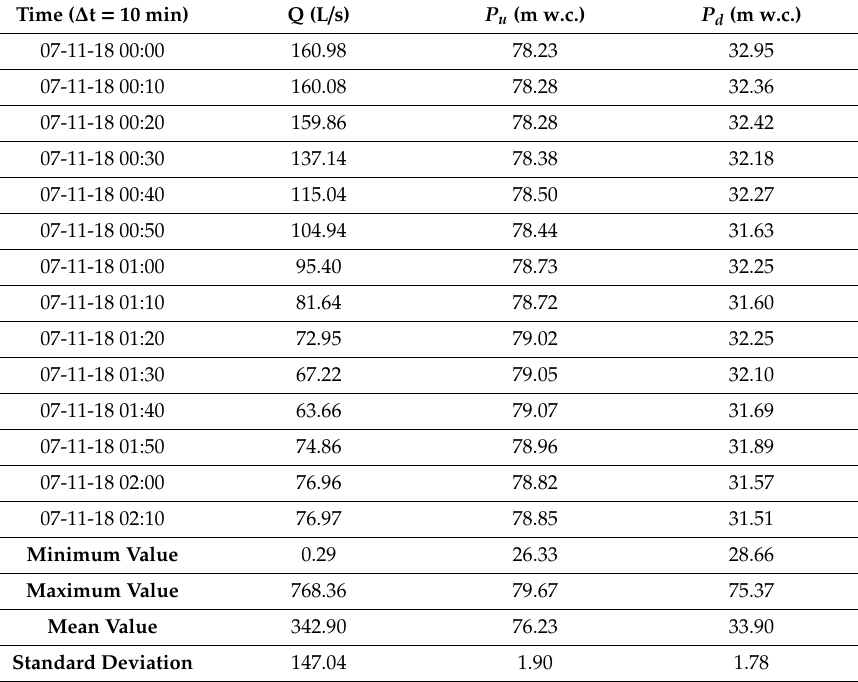
Table 2. Data recovered from an analyzed